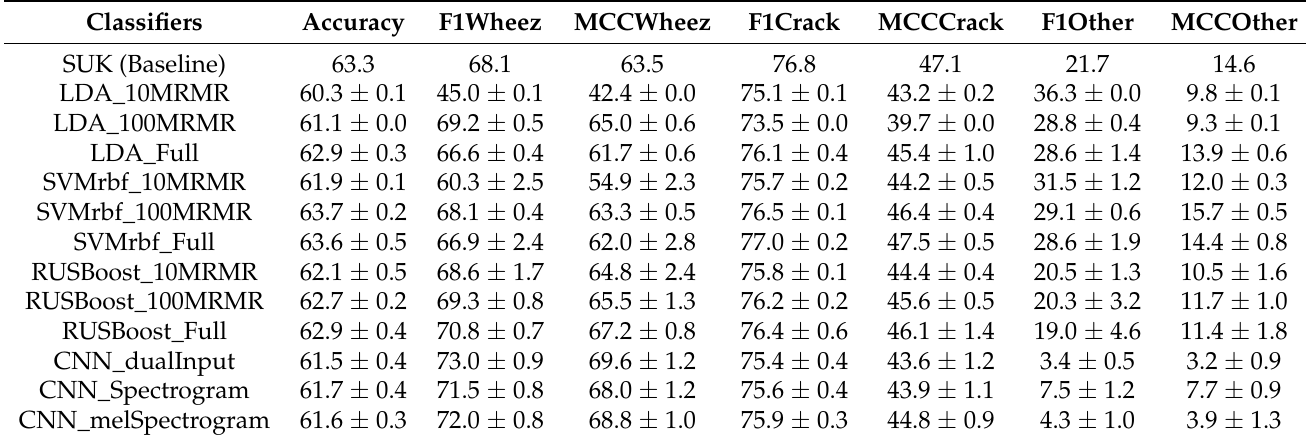
Table 11. Performance results obtained with 3 classes (crackle vs. wheeze vs. other)—training: fixed duration; testing: variable duration.